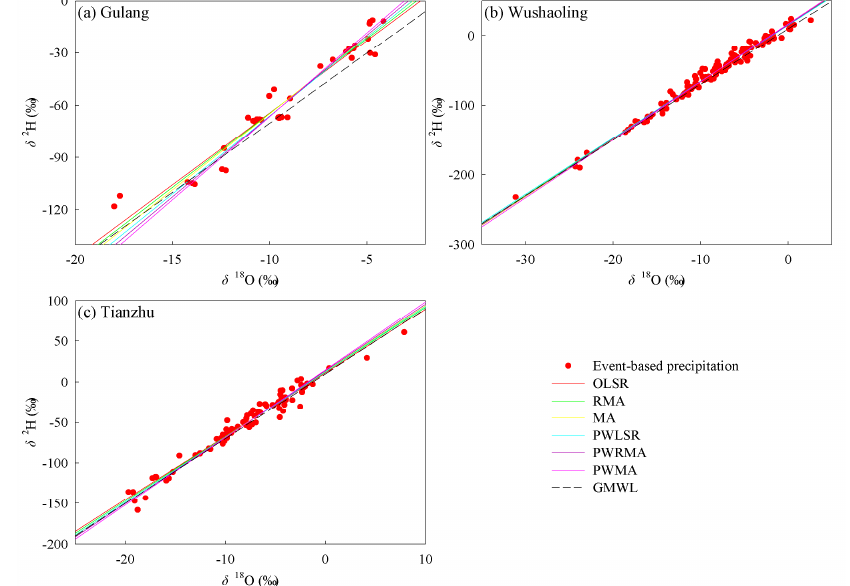
Figure 2. The Local Meteorological Water Line (LMWL) at the three sites; the Global Meteoric Water Line (GMWL) was also shown for reference. ( a – c ) are the LMWL at Gulang, Wushaoling, and Tianzhu, respectively. Table 5. Parameters of the fit for OLSR (ordinary least squares regression), RMA (reduced major axis regression), MA (major axis regression), PWLSR (precipitation weighted least squares regression), PWRMA (precipitation weighted reduced major axis regression), PWMA (precipitation weighted major axis regression) regressions at each site in the Qilian Mountains.